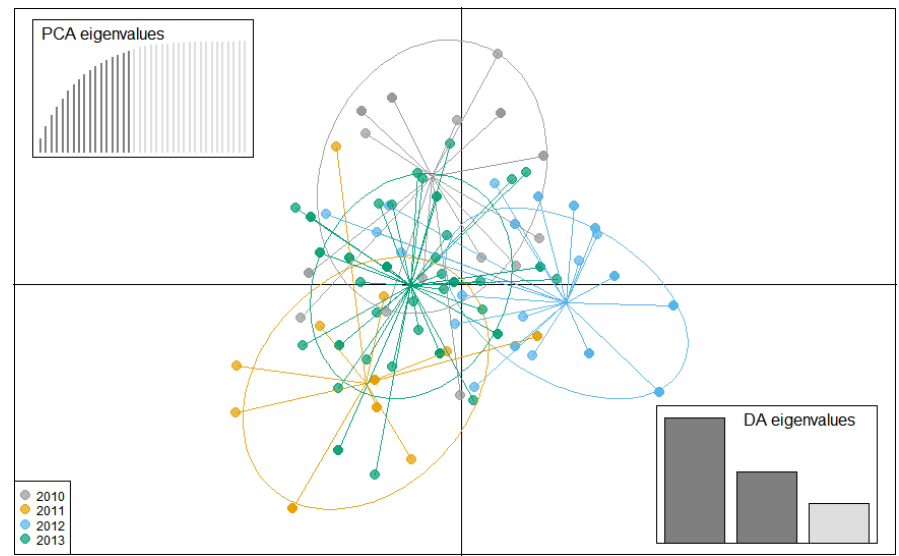
Figure 5. Minimum spanning network (MSN) inferred from simple sequence repeat (SSR) markers of P. infestans collected from ten locations (non-clone corrected) of Pskov region in north-west Russia during years 2010 − 2013. Each node represents multilocus genotypes (MLGs) and the size is proportional to the number of individuals sharing the same SSR allele profile. The thickness of the lines represents the Bruvo’s genetic distance between two nodes (the further the genetic distance the lighter the color and thinner the line). MLGs from the same location are color-coded.